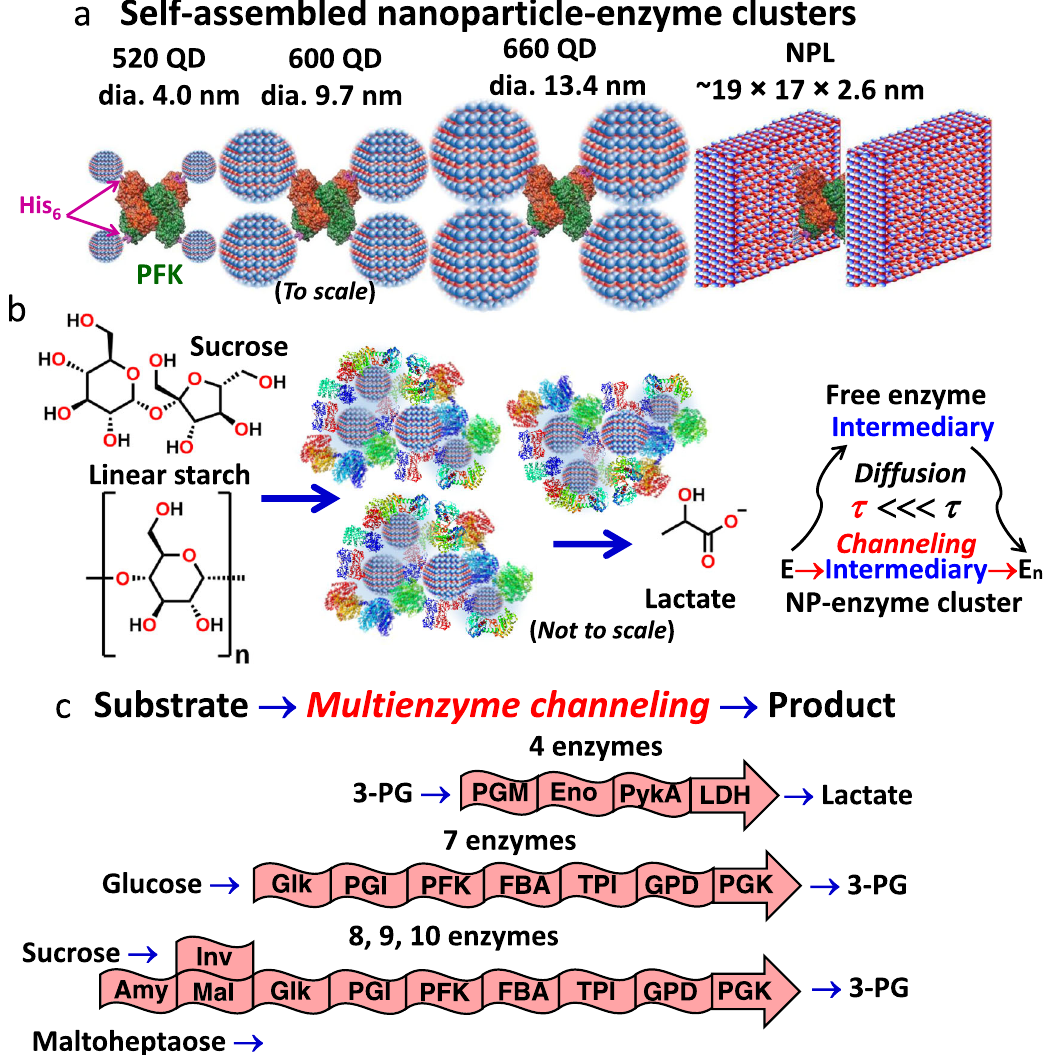
Fig. 1 | Nanoparticles, catalytic nanoclusters, and enzymatic pathways. a Multiple His 6 -termini (purple) on the multimeric enzymes coordinate to the NP surfaces and functionally crosslink them into nanoclusters as shown with phos- phofructokinaseI(PFK,PDB#1PFK)andthethreedifferentsizesofQDsalongwith NPLs used at a scale relative to PFK. NPLs are shown angled for perspective. b Schematic depicting the self-assembled QD enzyme clusters forming multi- enzyme cascades that are the focus of this study. QDs are mixed with stoichio- metric ratios ofenzymes thatconstitute a targeted cascade and